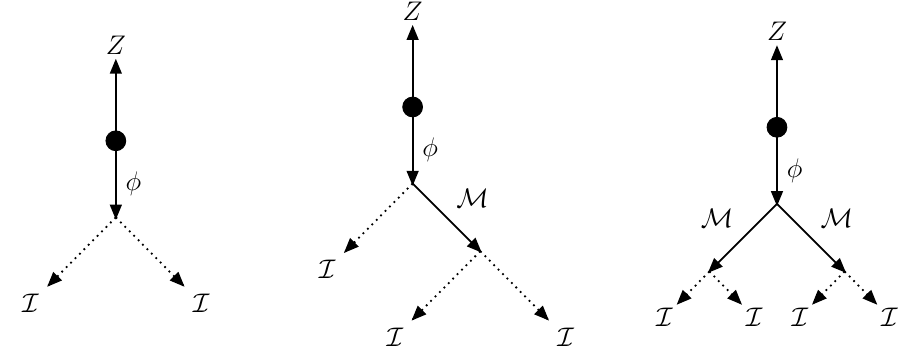
Figure 2. Initial state radiation topologies where the Z boson is radiated from the inital state and then the scalar resonance decays into invisible